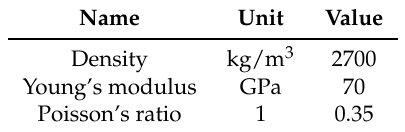
Table 1. Material properties of the aluminium (A2024-T351) workpiece.